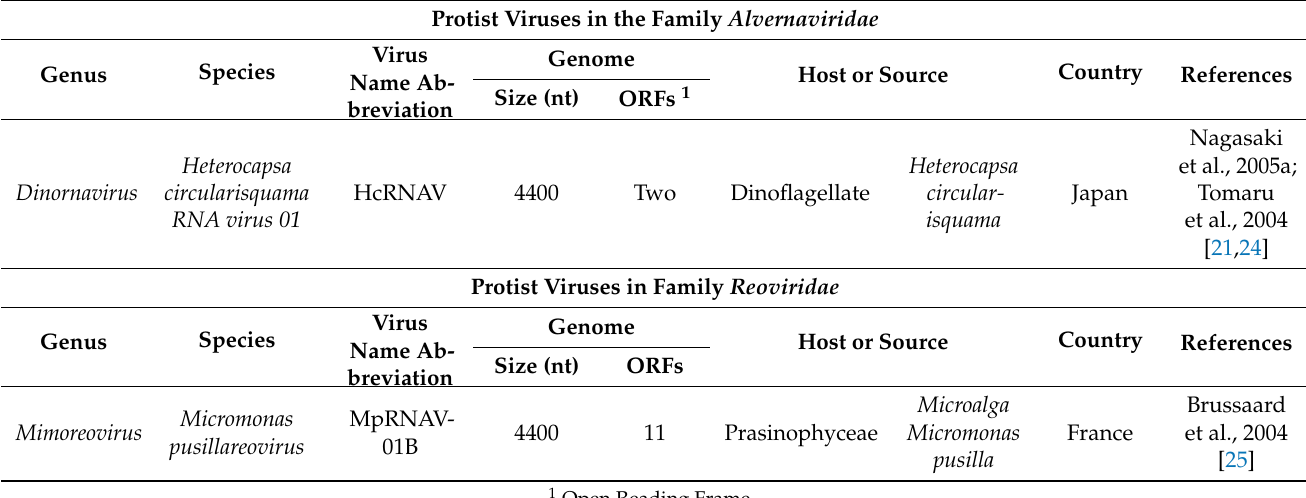
Table 2. RNA viruses discussed in this review in the families Alvernaviridae and Reoviridae. Protist Viruses in the Family